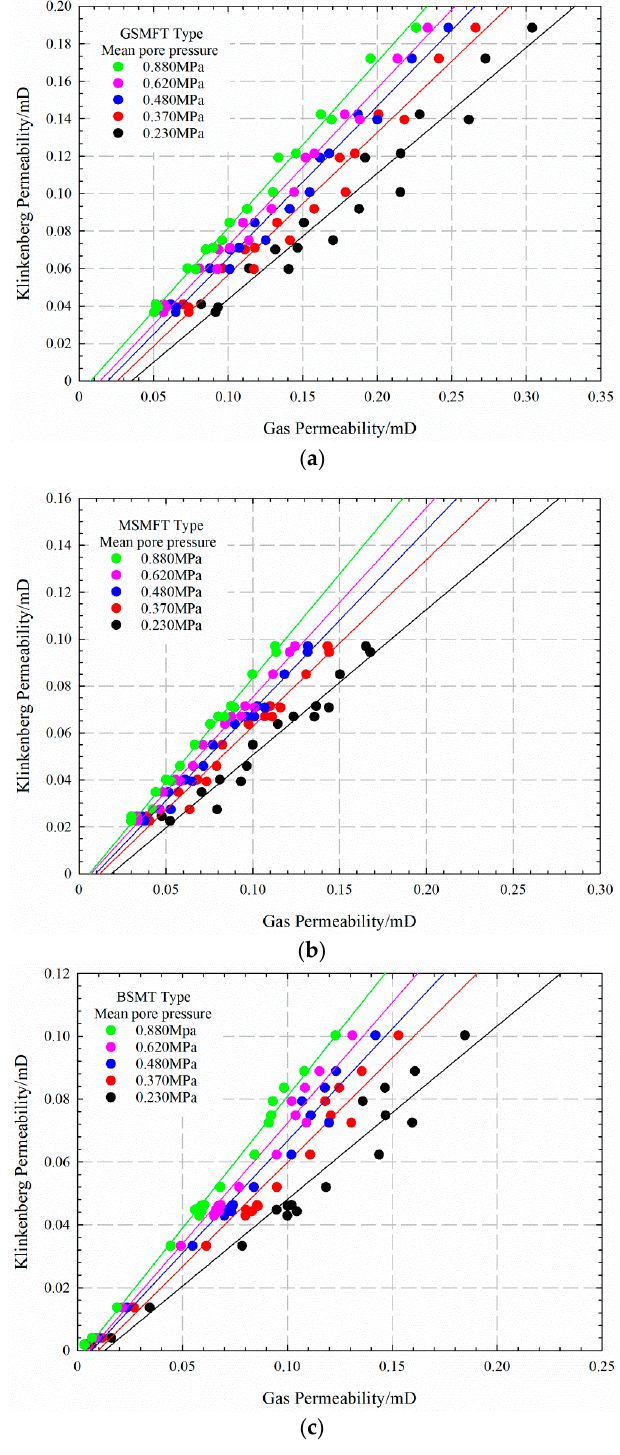
Figure 12. Klinkenberg permeability versus gas permeability for different pore-throat structure types: ( a ) GSMFT, ( b ) MSMFT, and ( c ) BSMT.